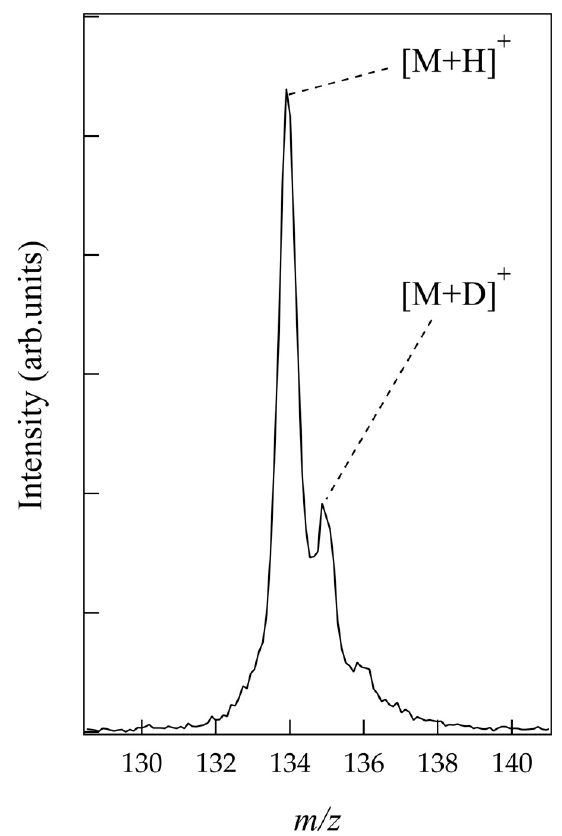
Figure 8. SIMS spectra of an Asp ( m/z = 133 for M) film by the bombardment of (D 2 O) 1500 + at an acceleration voltage of 5 kV. The ion beam fluence is 2.0 × 10 11 ions/cm 2